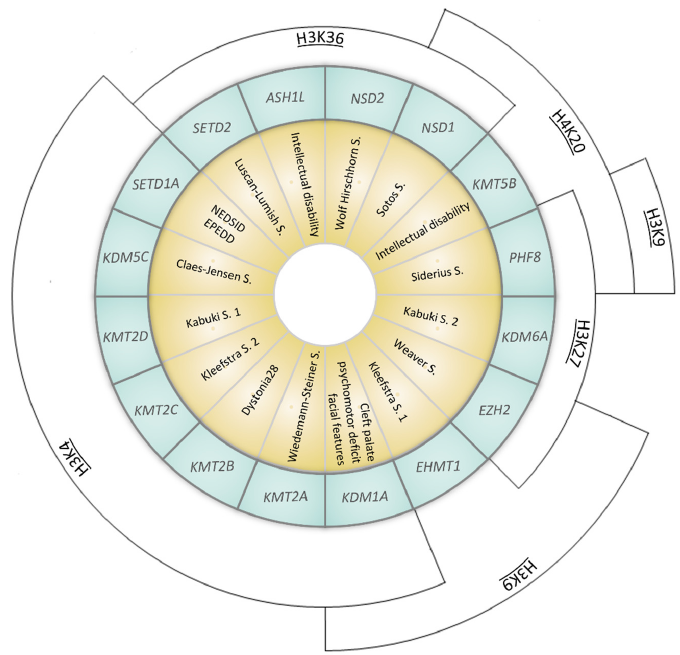
Figure 2. Representation of syndromes caused by mutations in genes coding for KMTs (Lysine methyl- transferases) or KDMs (Lysisne demethylases). Syndromes (yellow inner ring) and the corresponding causative gene (coding for KMTs or KDMs, listed in the middle blue ring) are represented. The outer arcs indicate the site of epigenetic modification (NEDSID: Neurodevelopmental disorder with speech impairment and dysmorphic facies; EPEDD: Epilepsy, early-onset, with or without developmental